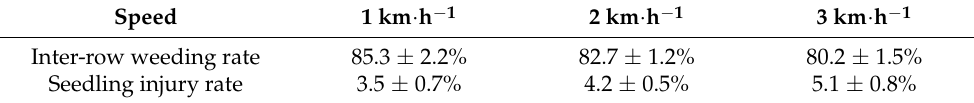
Table 6. Inter-row weeding rate and seedling injury rate of machine at different speeds. Speed Inter-row weeding rate